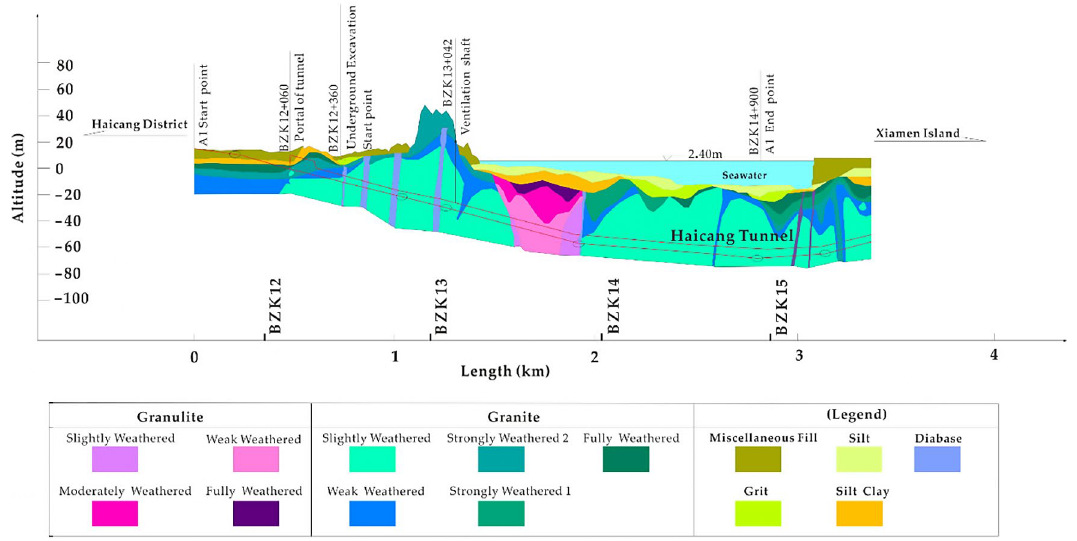
Figure 2. Geographical profile of section A1 of Haicang Tunnel to display the geological